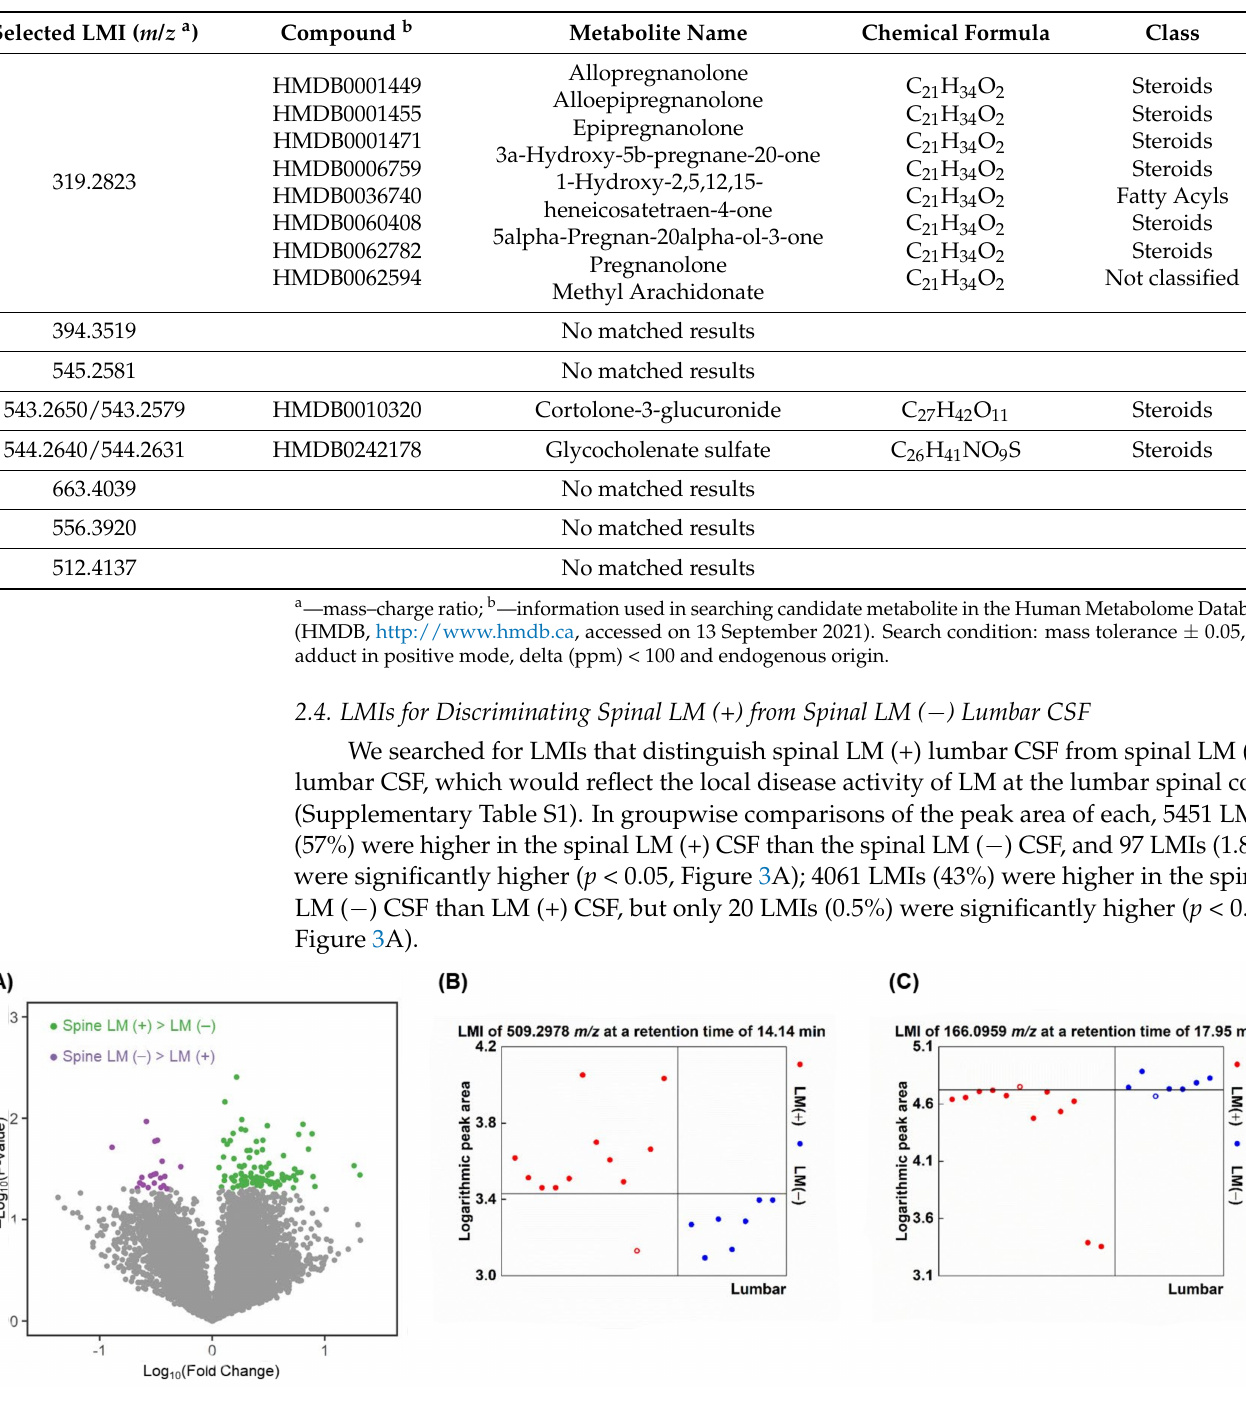
Figure 3. Evaluation of discriminative LMIs between spinal LM (+) CSF and ( − ) lumbar CSF. ( A ) Vol- cano plot illustrating significantly discriminative LMIs for each group. X-axis: Log 10 (mean